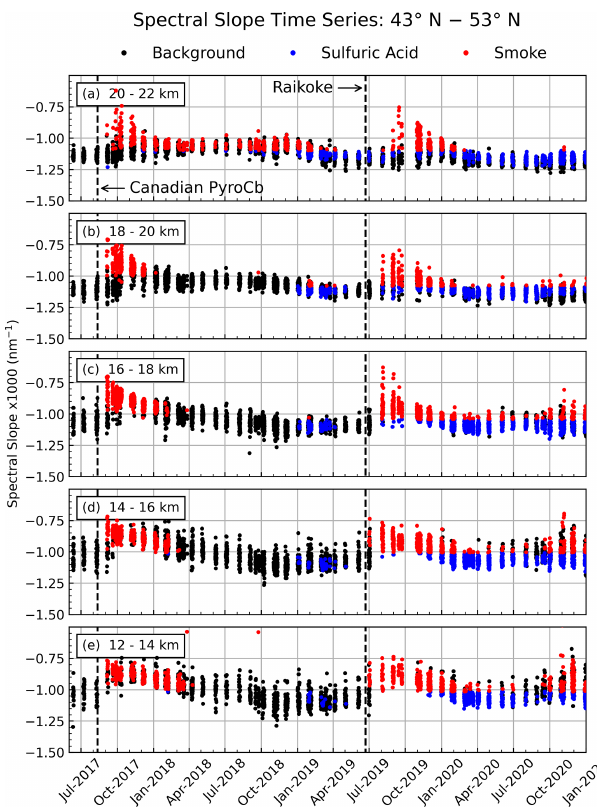
Figure 20. Time series of the spectral slope from June 2017 through January 2021 between 43 and 53 ◦ N. The vertical dashed lines in- dicate the start of the 2017 Canadian pyroCb and the 2019 Raikoke